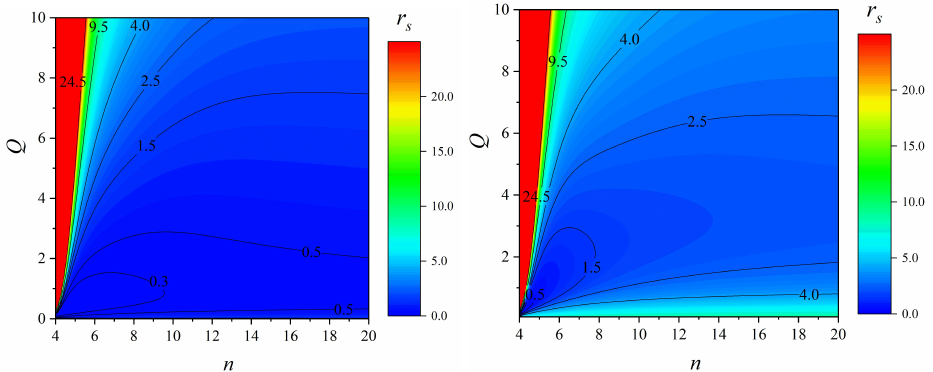
Figure 5. Radii of SS for different n , Q ; M = 1 ( left ) and M = 5 ( right ).